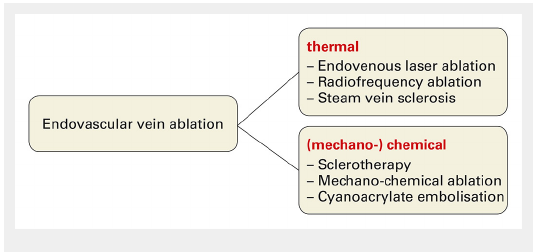
Overview of the different techniques of endovascular vein